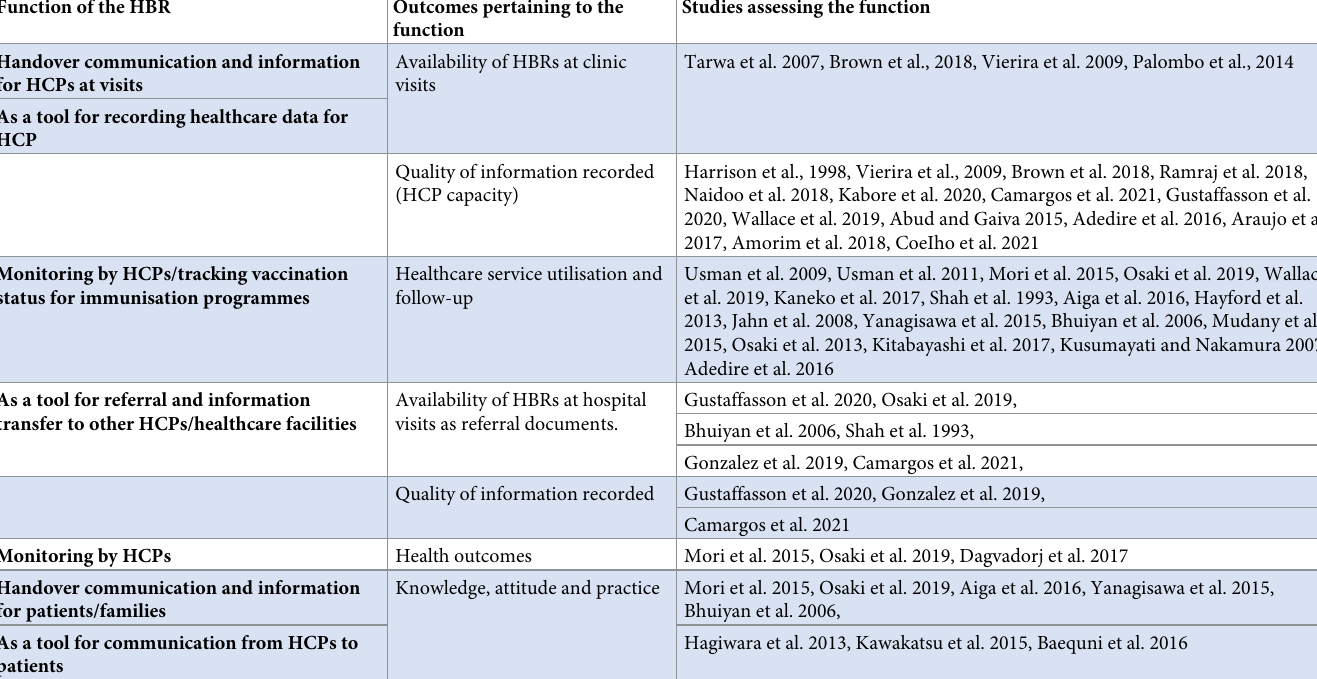
Table 2. Functions of HBRs evaluated in the included